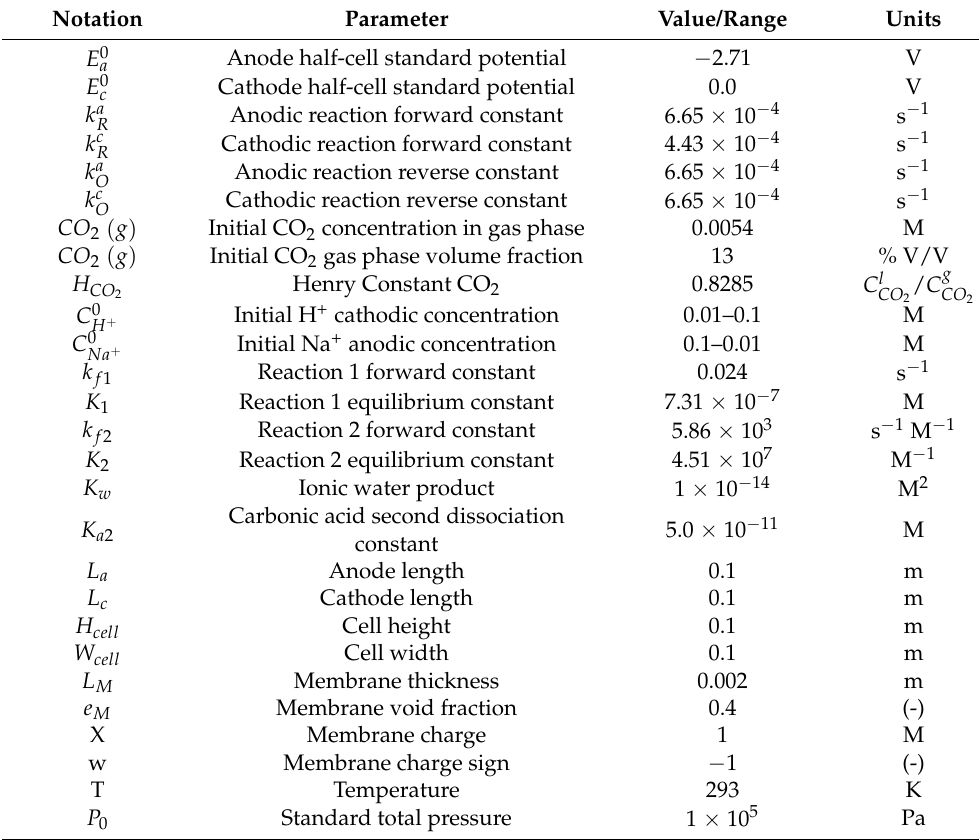
Table A1. Values used in the